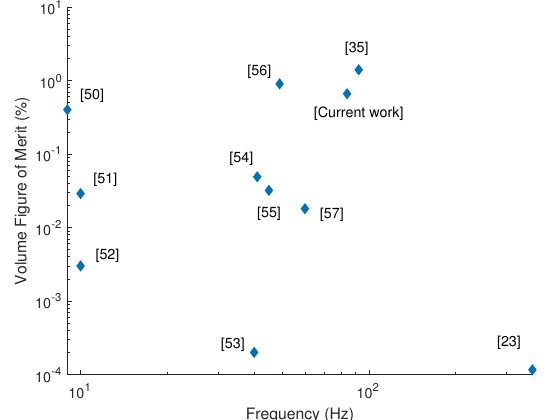
Figure 10. Comparison of the optimized proposed harvester FoM v with the current state-of-the- art